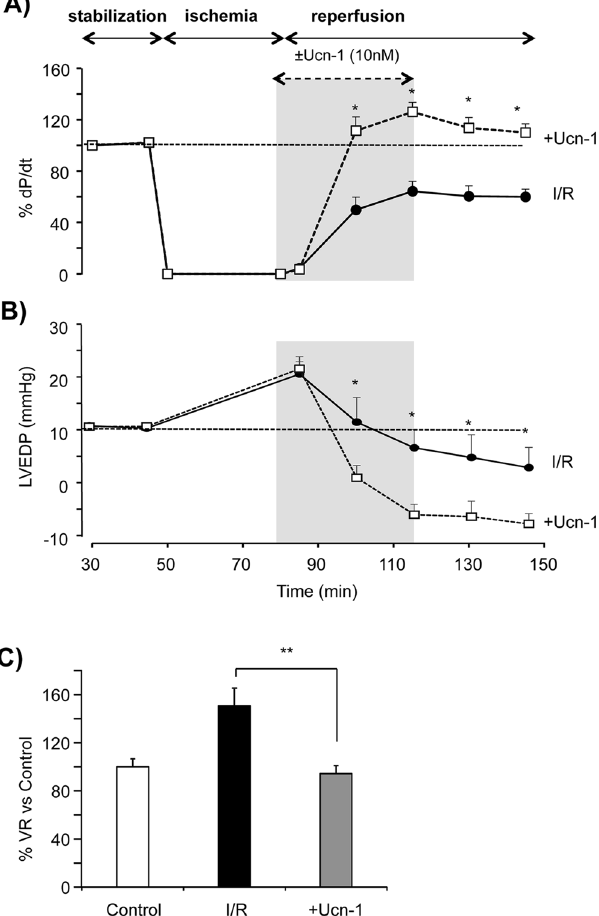
Figure 1. Urocortin-1 recovers the hemodynamic function of Langendorff perfused rat hearts submitted to I/R. ( A ) Graph shows summary data of the contractility expressed as + dP/dt (%) in hearts subjected to ischemia/reperfusion protocol (I/R, full circle, n = 5), and in hearts treated with 10 nM Ucn-1 ( + Ucn-1, open square, n = 5). Ucn-1 was applied 5 minutes before ischemia ends and during the first 30 minutes in reperfusion as indicated by area in grey. ( B ) Shows summary data of the left ventricular end diastolic pressure (LVEDP, mmHg) in the same conditions as in “A”. ( C ) Bar graph shows the changes in the mean of vascular resistances (VR, mmHg * min/ml). Values were taken 60 minute after reperfusion and were normalized to controls’ values. Data are means ± S.E.M. “ * ” and “ ** ” indicate significance at p < 0.05 and p < 0.01 of I/R vs +